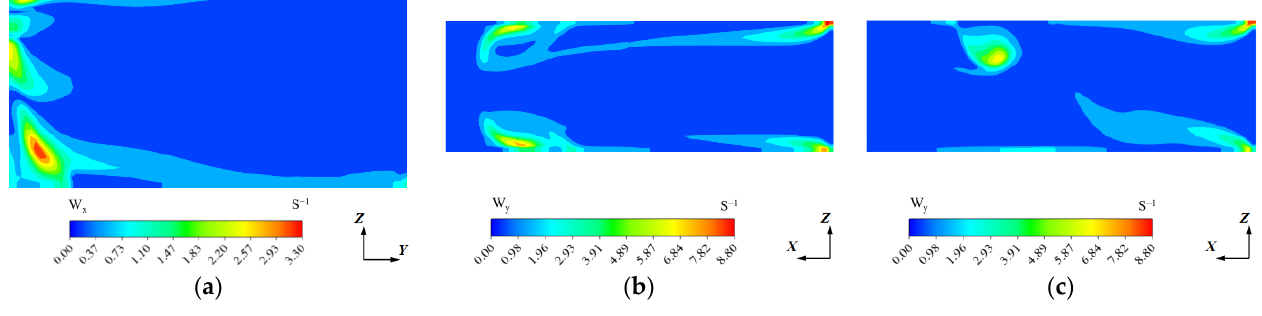
Figure 19. Maximum vorticity intensity of each wall. 3.3. Flow Pattern at the Bell Mouth Figure 20 shows the pressure distribution at the bell mouth at different time points. It can be seen from the figure that the pressure in the middle of the bell mouth is lower than the sidewall and the flow rate is higher. The distribution of the middle low-pressure zone changes with the rotation of the impeller. However, there is a low-pressure area near the rear wall of the closed sump. The position of the low-pressure area does not change with the rotation of the impeller. When the blade faces the low-pressure area (2/5 T), the